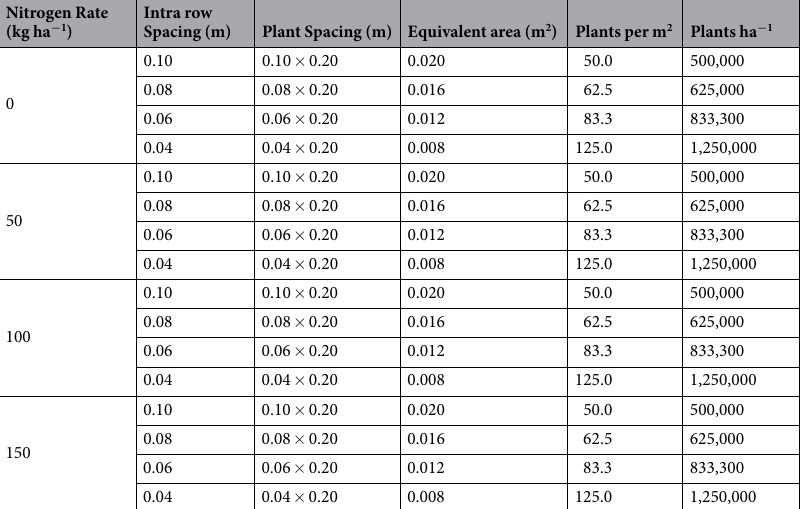
Table 2. Treatment combinations of fertilizer rates, plant spacing and plant populations. 0.1 m, 0.08 m, 0.06 m and 0.04 m are the intra row spacing when multiplied each by 0.2 m common inter row spacing provides 500000, 625000, 833300 and 1250000 plant population density ha − 1